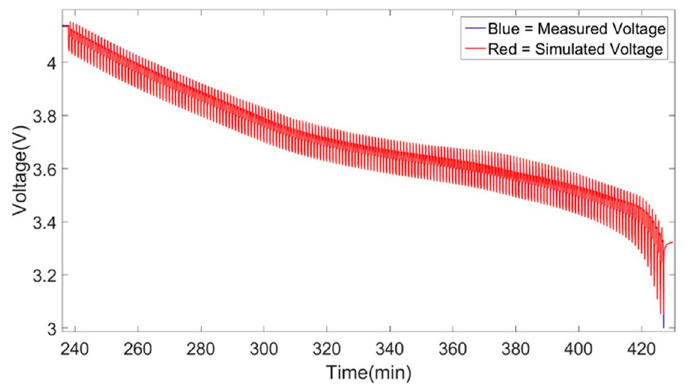
Figure 22. 2nd order Thévenin model measured and simulated DDP comparison at 25 °C with advanced Kalman filtering and advanced characterization.